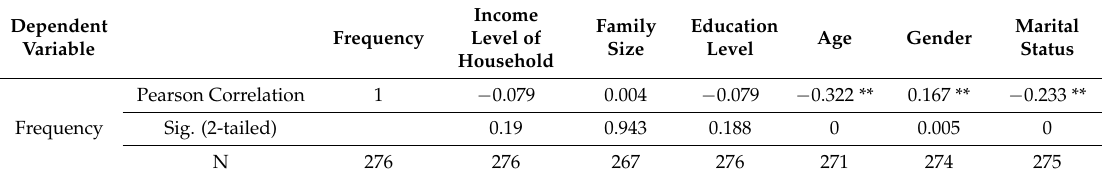
Table 1. Correlation between the survey respondents’ frequency of purchasing food online and the consumers’ socio-economic characteristics.